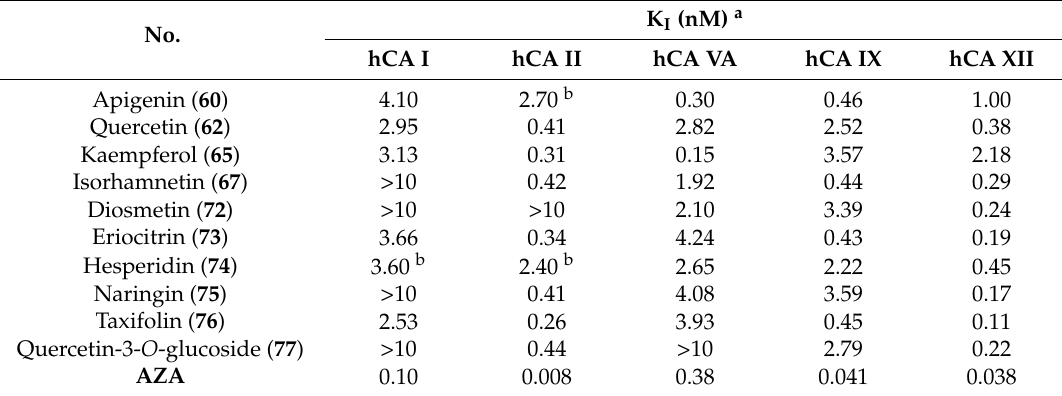
Table 9. Inhibition constant K I values ( µ M) of human carbonic anhydrase I, II, VA, IX, and XII isoforms for compounds 60 , 62 , 65 , 68 , 72 – 77 and acetazolamide ( AZA ).